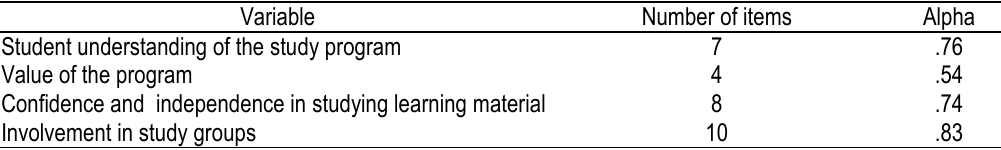
Table 1. The Alpha Coefficient of the